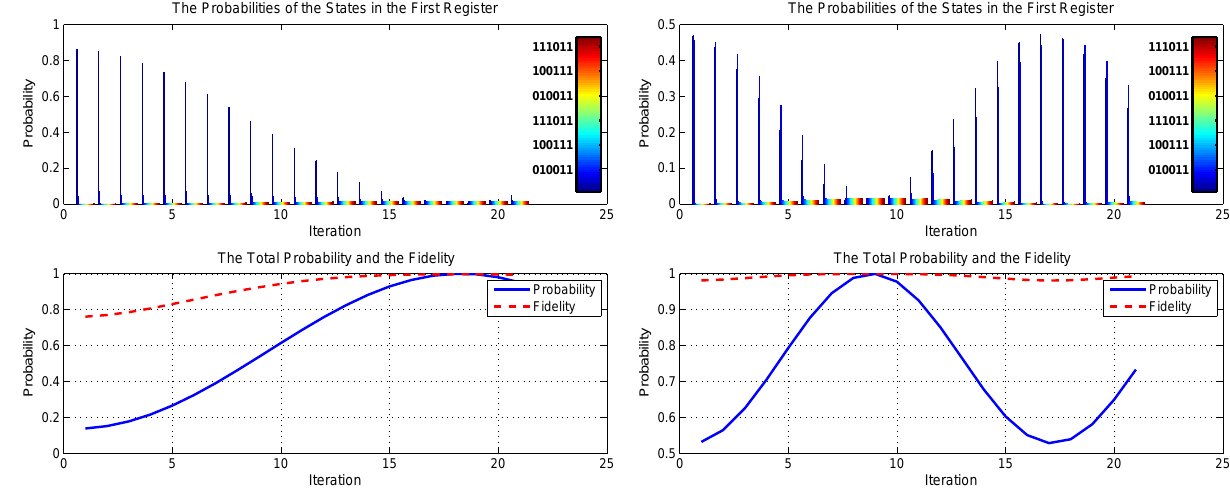
(b) For the generated random input | x (cid:105) = ( . 7730 . 1919 . 1404 . 5881) T . Figure 6: The simulation results of the quantum model for the example in Section 5 with two di ff erent input